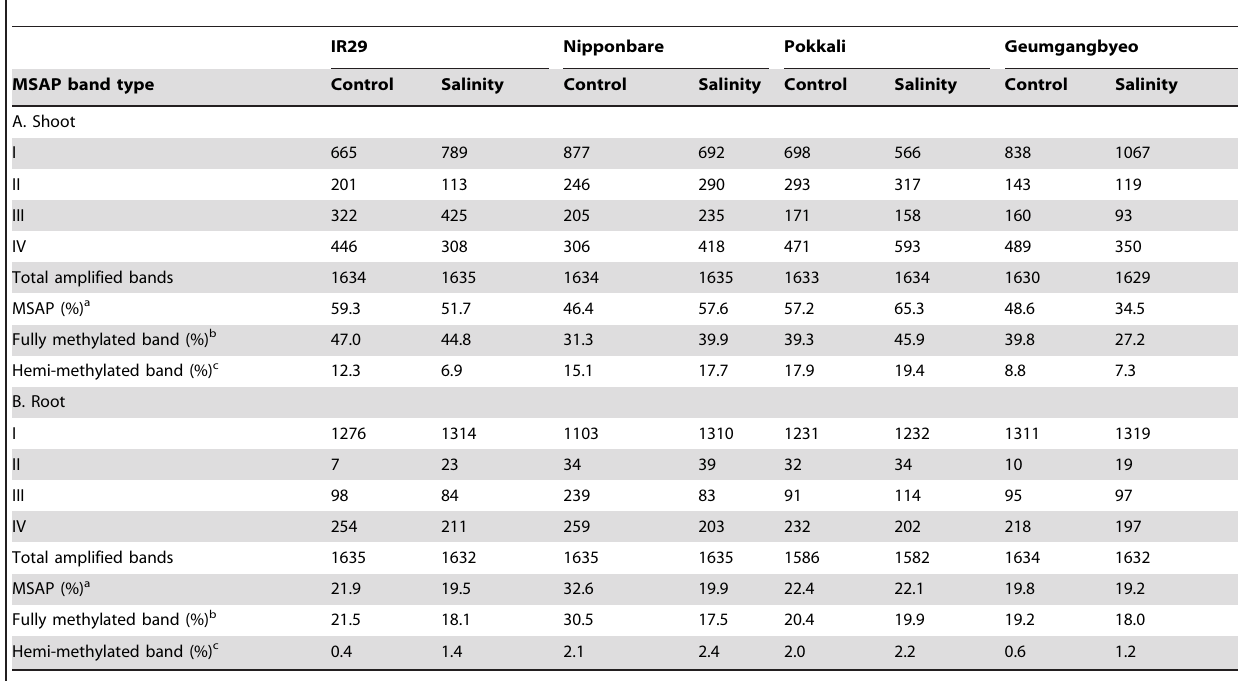
Table 1. DNA methylation changes in shoot and root at seedling stage under non-stress and salinity stress